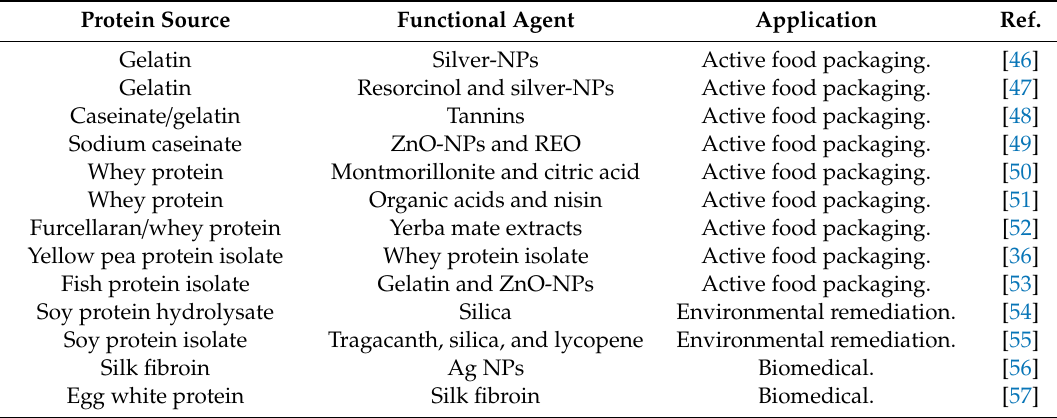
Table 2. Application of some functionalized protein-based materials.